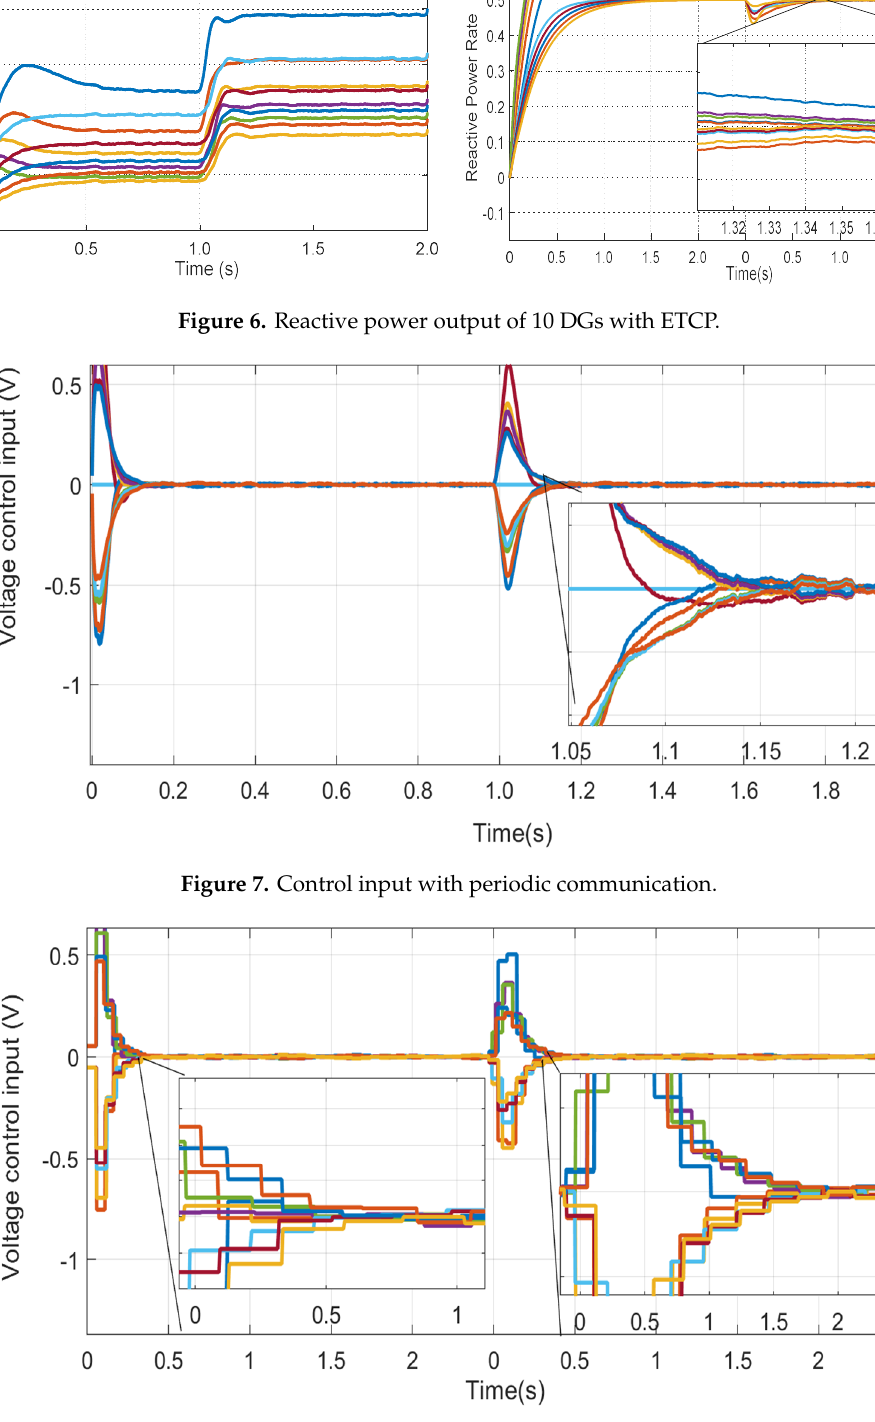
Figure 9. Triggering instant of 10 DGs with ETCP Figure 10. Total communication of ETCP and periodic communication 5.2. Case 2: Impact of Communication Time Delay It is necessary to analyze the impact of communication time delay on the performance of the proposed method. It is assumed that time delays happen between agent 1 and agent 2 with delay values: